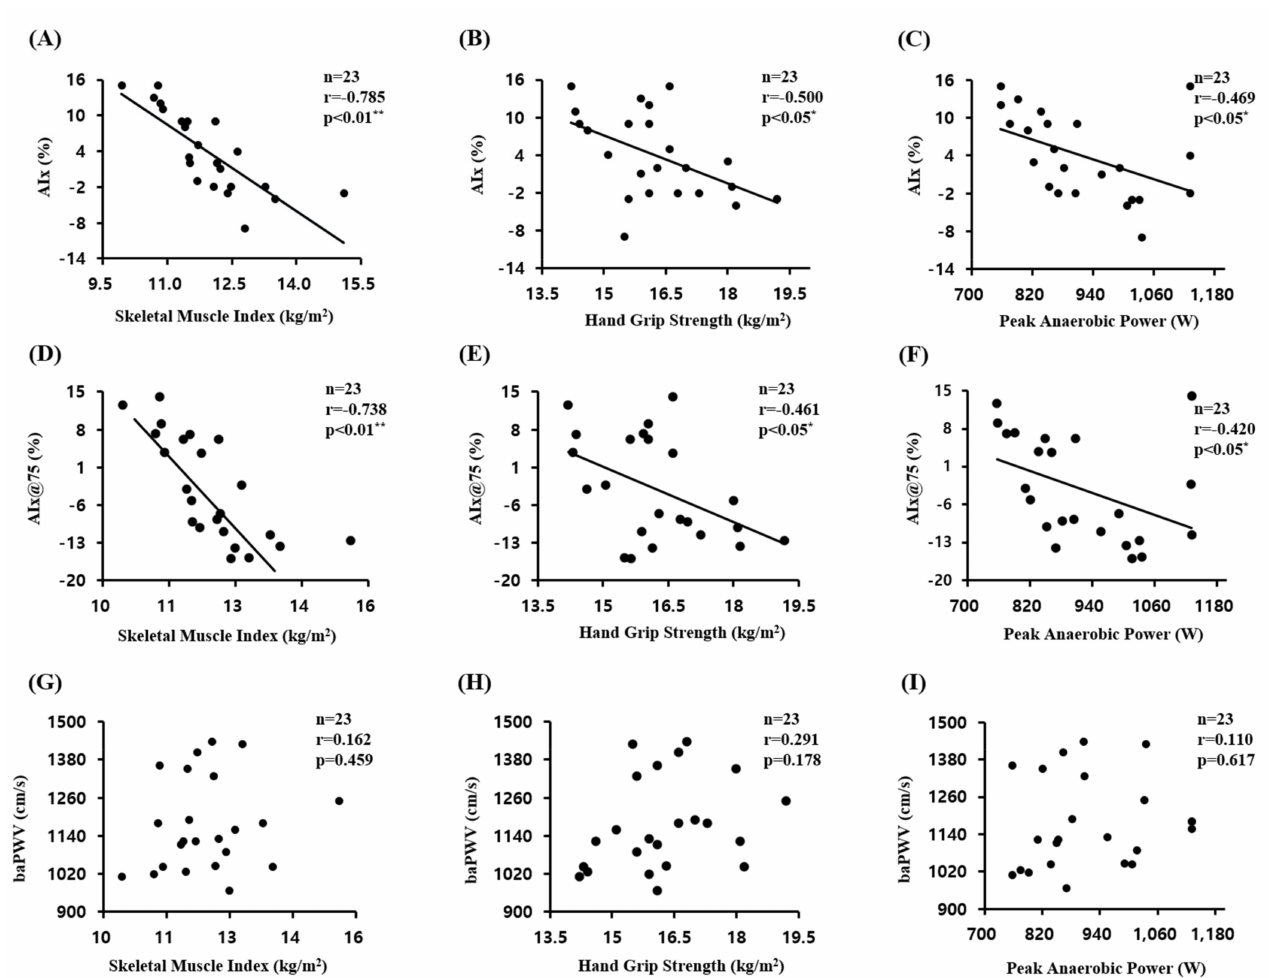
Figure 1. Associations between arterial stiffness (AIx, AIx@75, baPWV) and muscular variables (skeletal muscle mass, muscular strength, anaerobic power). Pearson’s correlations between AIx and skeletal muscle index ( A ), hand grip strength ( B ), and peak anaerobic power ( C ). Pearson’s correlations between AIx@75 and skeletal muscle index ( D ), hand grip strength ( E ), and peak anaerobic power ( F ). Pearson’s correlations between baPWV and skeletal muscle index ( G ), hand grip strength ( H ), and peak anaerobic power ( I ). * p < 0.05, ** p <